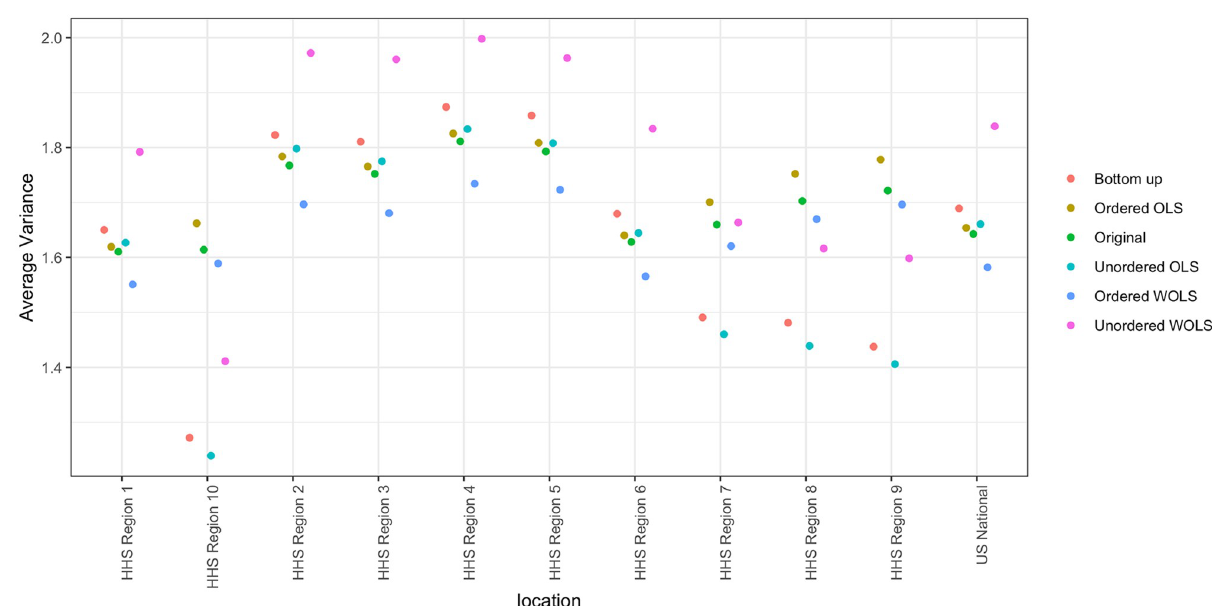
Fig 9. Average variance of forecasts, averaged over season, epiweek, target, and model. Notice that the unordered WOLS increases the variance across HHS regions, which is reflected in the improvements under single-bin scoring. However, the variance of the unordered WOLS decreases at the national level, which is also the only region without significant benefit under single-bin scoring. The optimal model under multi-bin scoring (ordered OLS) retains the same variance of the original forecast distribution for the HHS regions, but slightly increases the variance slightly for the nation. This demonstrates the effect of the scoring has on projection method